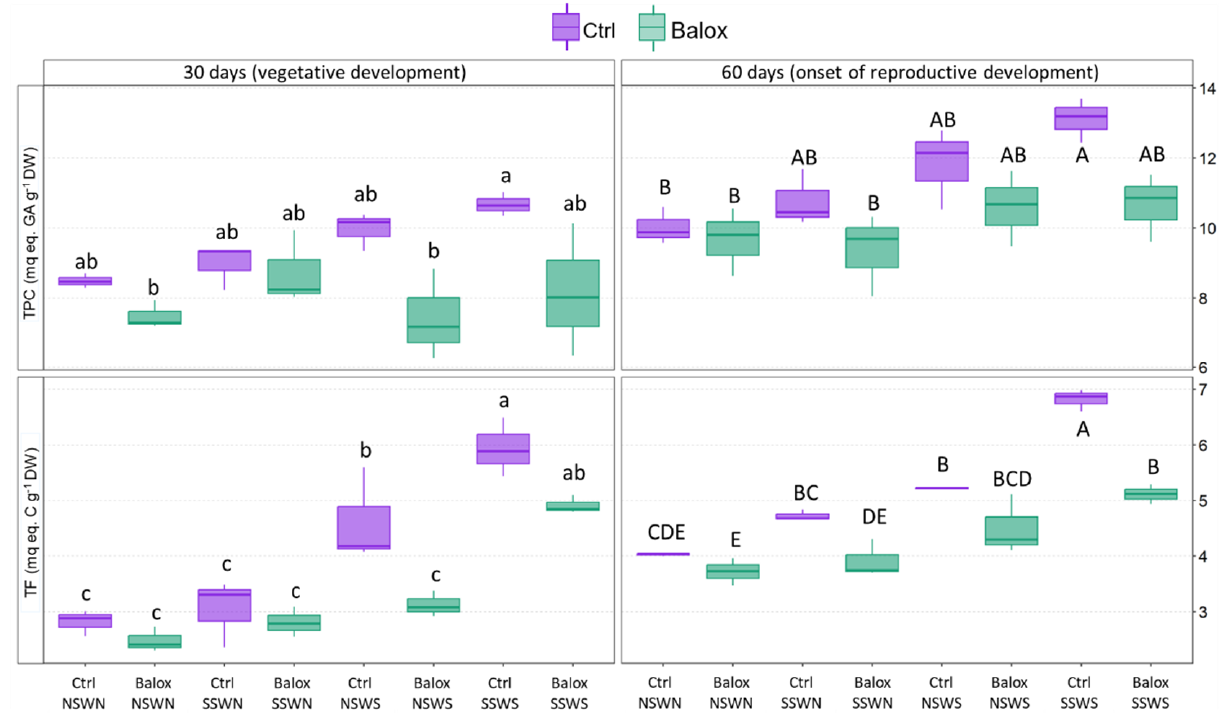
Figure 11. Content of total phenolic compounds (TPC) and total flavonoids (TF) in leaves of tomato plants subjected to increasing salinity by different combinations of saline or non-saline soil and irrigation water; the plants were treated, or not, with the biostimulant containing polyphenols at 1.4% ( w / w ) and glycine betaine at 3.0% ( w / w ) at a dose of 0.4 mL L − 1 of irrigation water. The control treatments without biostimulant (Ctrl) and the treatments with biostimulant (BALOX ® ) are defined as follows: (i) NSWN: Non-saline soil (EC = 2.28 dS/m) and non-saline water (EC = 0.91 dS/m); (ii) SSWN: Saline soil (EC = 8.55 dS/m) and non-saline water (EC = 0.91 dS/m); (iii) NSWS: Non-saline soil (EC = 2.28 dS/m) and saline water (EC = 10.50 dS/m); (iv) SSWS: Saline soil (EC = 8.55 dS/m) and saline water (EC = 10.50 dS/m). The evaluation periods: 30 days and 60 days of treatment. The values are the means ± SE ( n = 3). Different letters above the bars (lowercase for 30 days and capital for 60 days of treatments) indicate significant differences between treatments, according to the ANOVA test ( p < 0.05). Statistical analyses were performed independently for the two treatment periods.